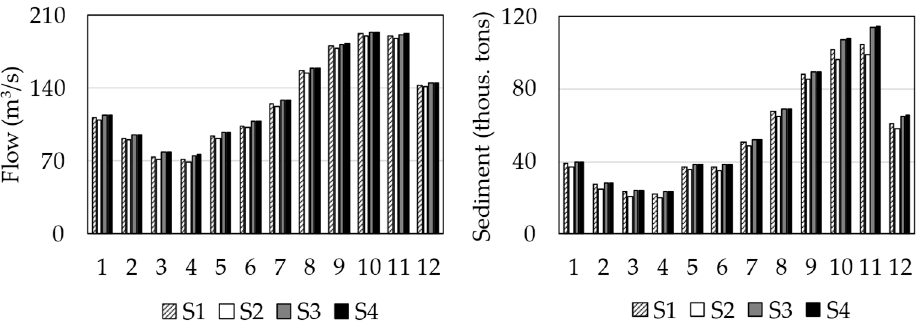
Figure 9. The differences for the average monthly total flow and sediment between the scenarios.